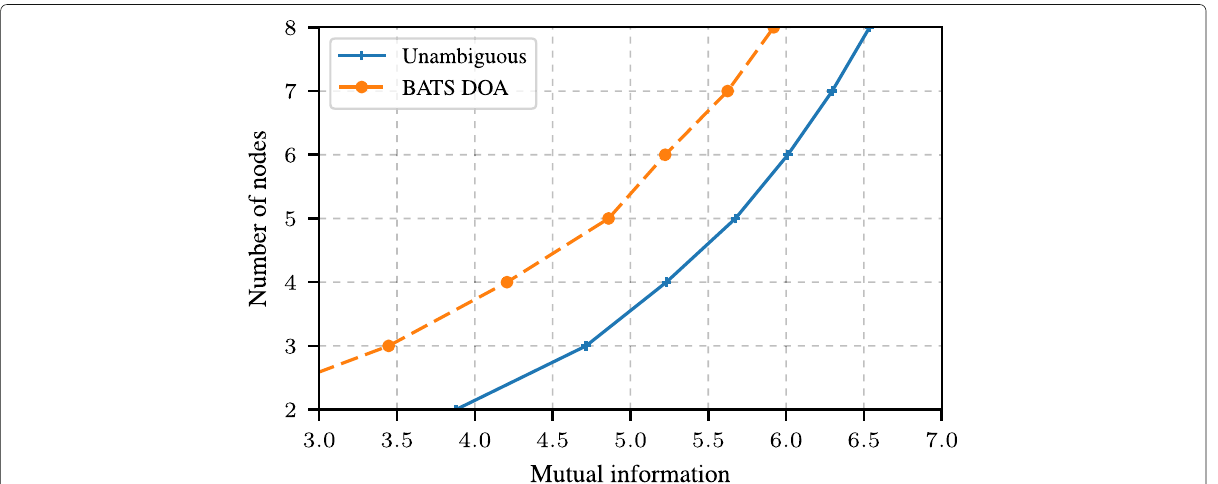
Fig. 15 Required number of sensor nodes to realize a requested amount of information gain by a network localization measurement